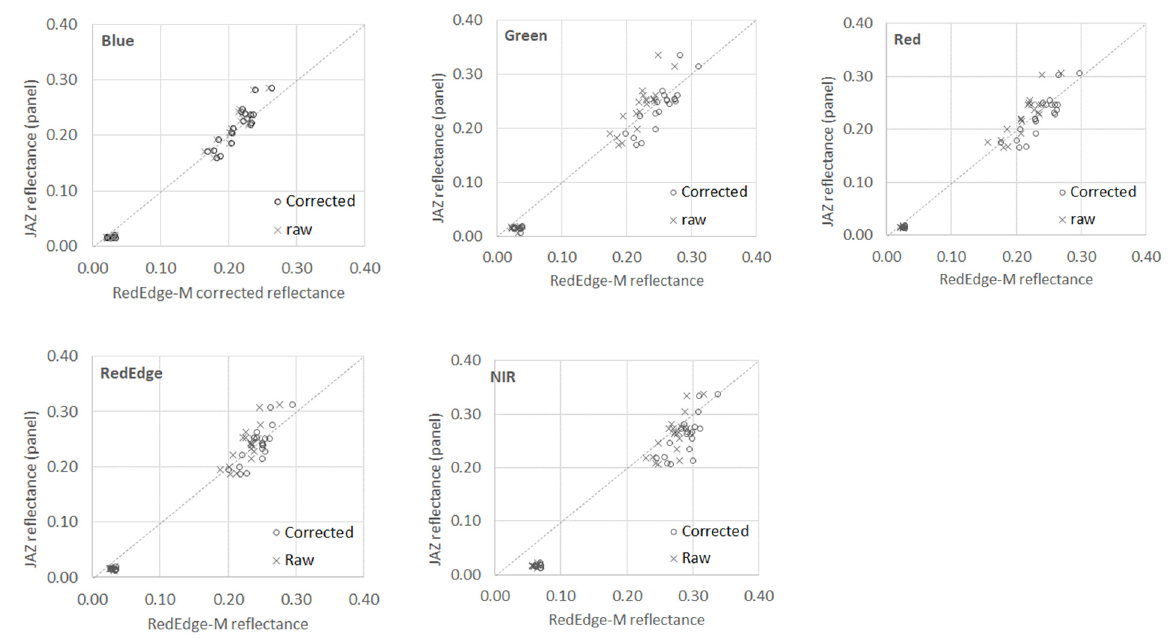
Figure 6. Comparison between the Jaz measured and the RedEdge-M reflectance of the three MAPIR panels: Black, dark grey, light grey. Both the raw and corrected reflectance values of the RedEdge-M camera are compared. All weather conditions are considered.